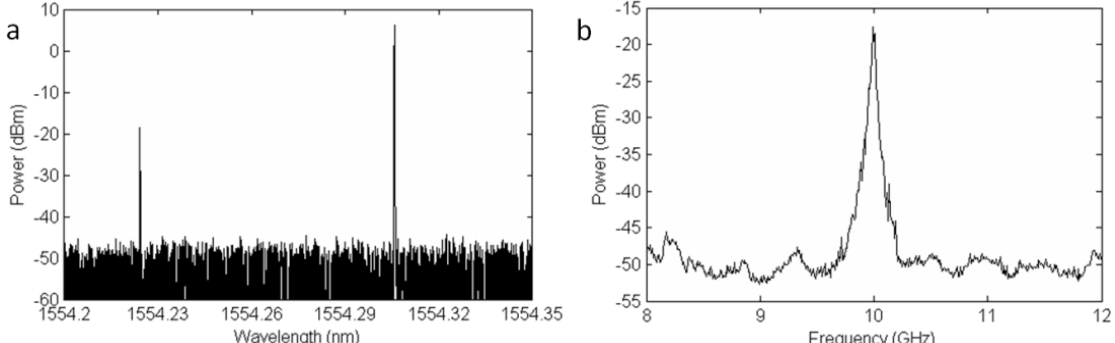
Figure 5. ( a ) Optical spectrum exiting the HNF; ( b ) Spectrum of the beat wave generated by the TLS output and its Brillouin scattering wave. Note that the peak is located at 9.992 GHz, in agreement with the 80.5 pm of separation measured in the optical